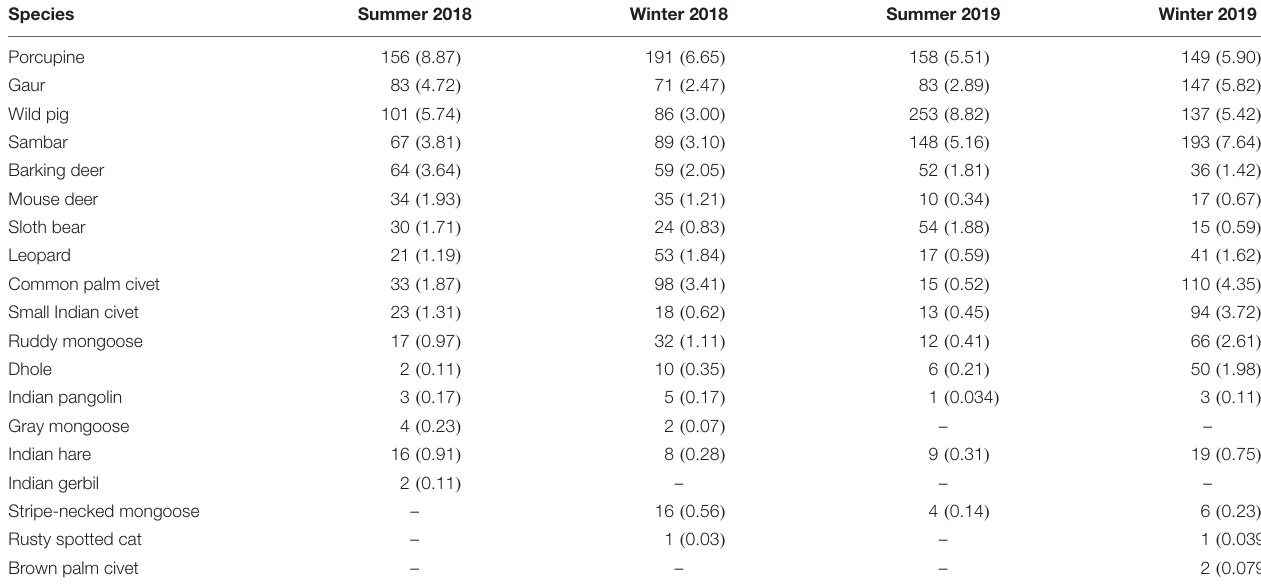
TABLE 3 | List of all species photo-captured during the study period from riparian forests of Koyna Wildlife Sanctuary. Species